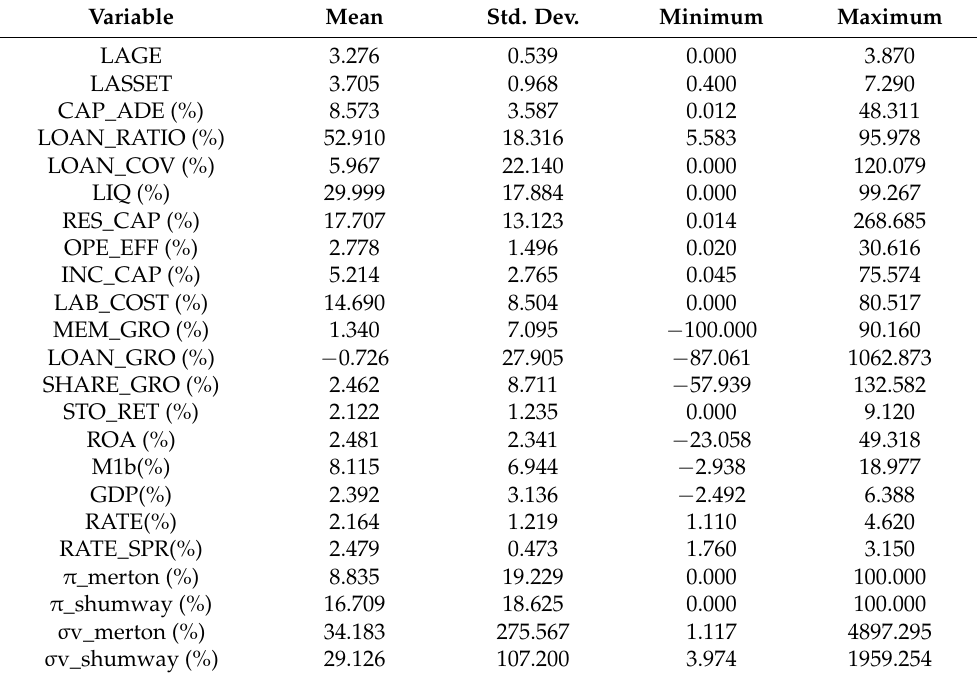
Table 2. Summary statistics: Time-varying covariates. Means and standard deviations from CULROC. Variable Mean Std. Dev. LAGE